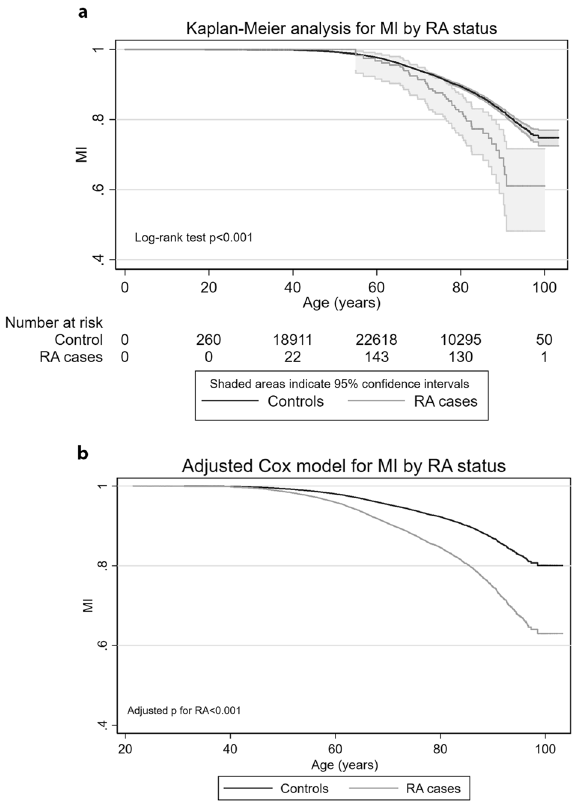
Figure 3. Estimates for myocardial infarction by RA status. Panel A: Kaplan–Meier curves, i.e. unadjusted model. Shaded areas indicate 95% confidence intervals. Panel B: Curves from Cox regression (Model 4, Table 2, adjusted for sex, CAD swGRS157, RA swGRS27, smoking, hypertension, total cholesterol, body mass index, previous cardiovascular disease, and diabetes). The analysis included 61,465 participants (2609 with and 58,856 without a myocardial infarction). Abbreviations: CAD: coronary artery disease; MI: myocardial infarction; RA: rheumatoid arthritis; swGRS: standardized, weighted genetic risk